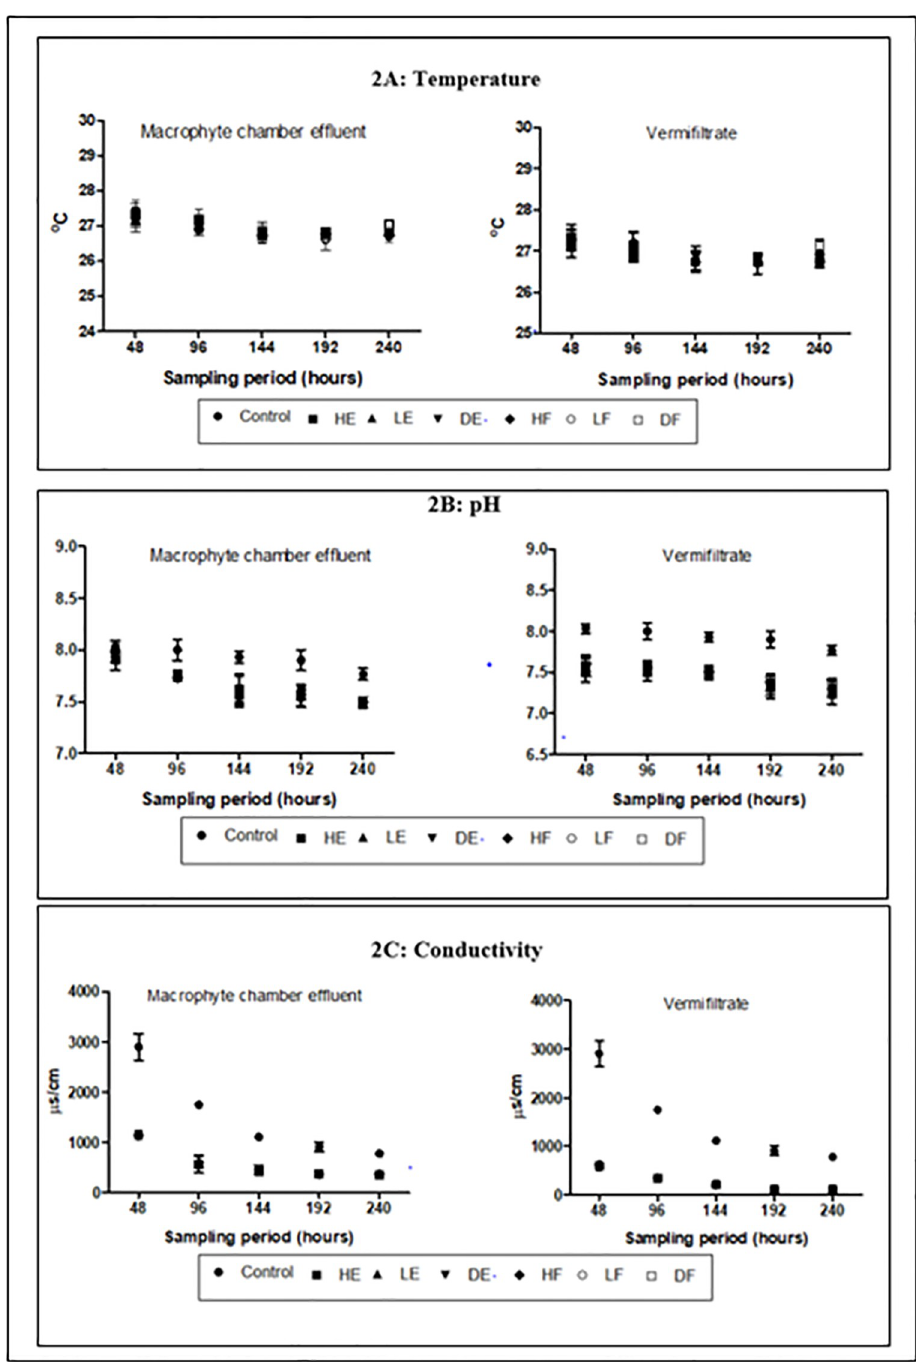
Fig 2. Physicochemical characteristics of effluent (A) Temperature (B) pH (C) Conductivity. https://doi.org/10.1371/journal.pone.0281953.g002 points. TSS in the wastewater followed similar trend (Fig 3B). High TSS ( > 200 mgl -1 ) was recorded in the wastewater and this significantly reduced (p < 0.05) at the end of the study in the effluent of all experimental setups. However, the control again had the least reduction (25.03 ± 0.2%) compared to the reductions in the effluents of the treatment setups (60%–